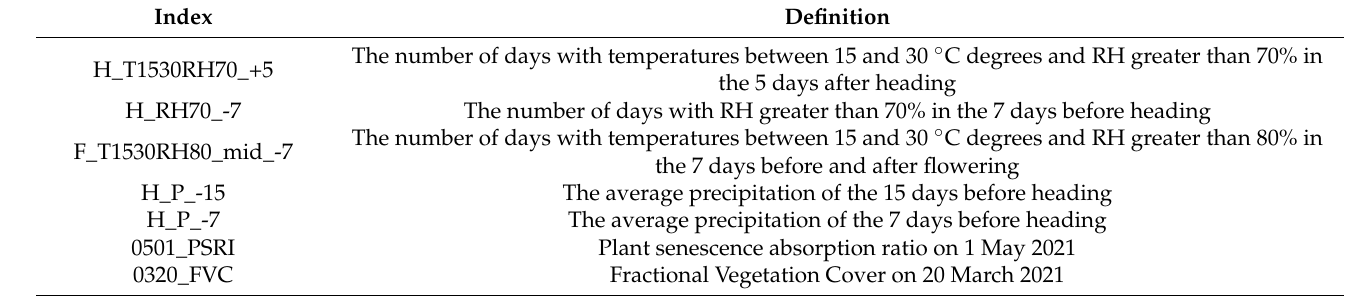
Table 2. Feature selection results based on logistic and L1 regularization and Fisher scores (10 May